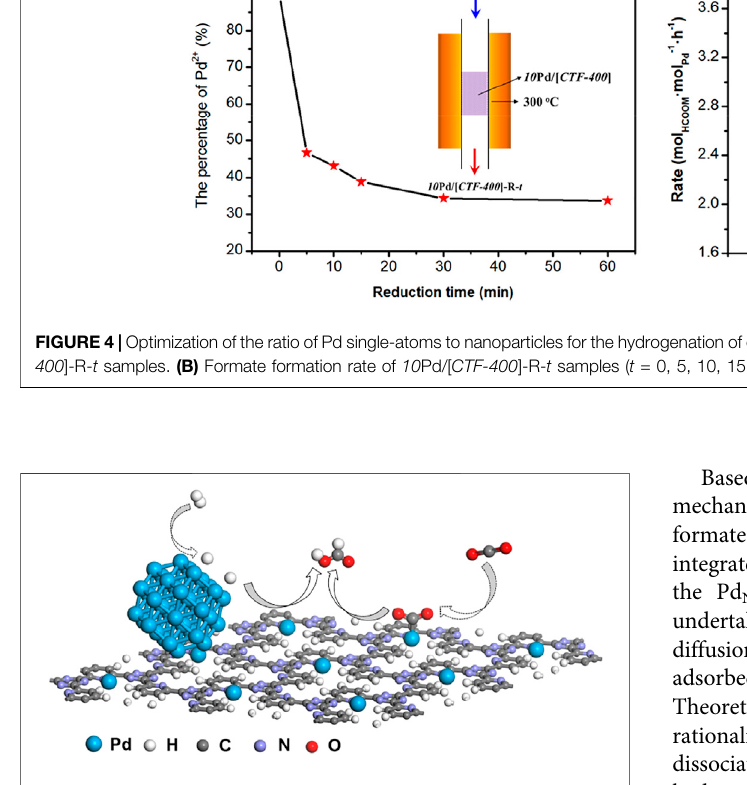
Frontiers in Chemistry |